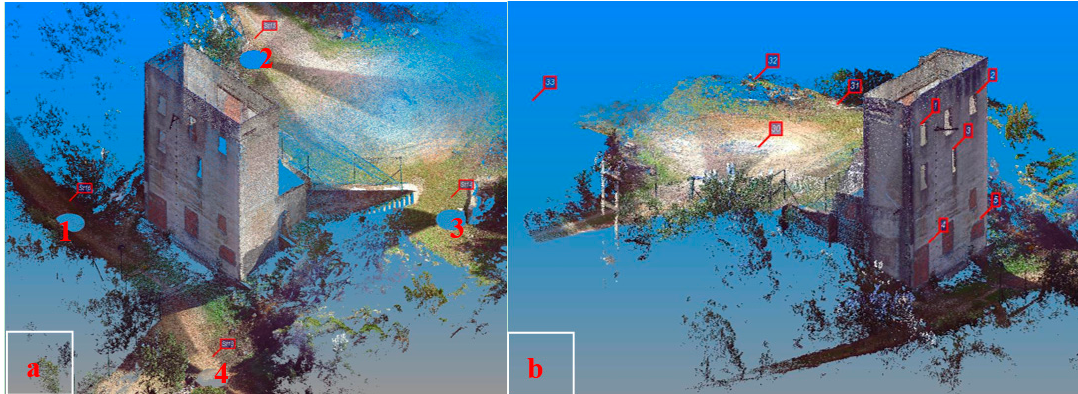
Figure 18. TLS station points ( a ), and GCPs ( b ).